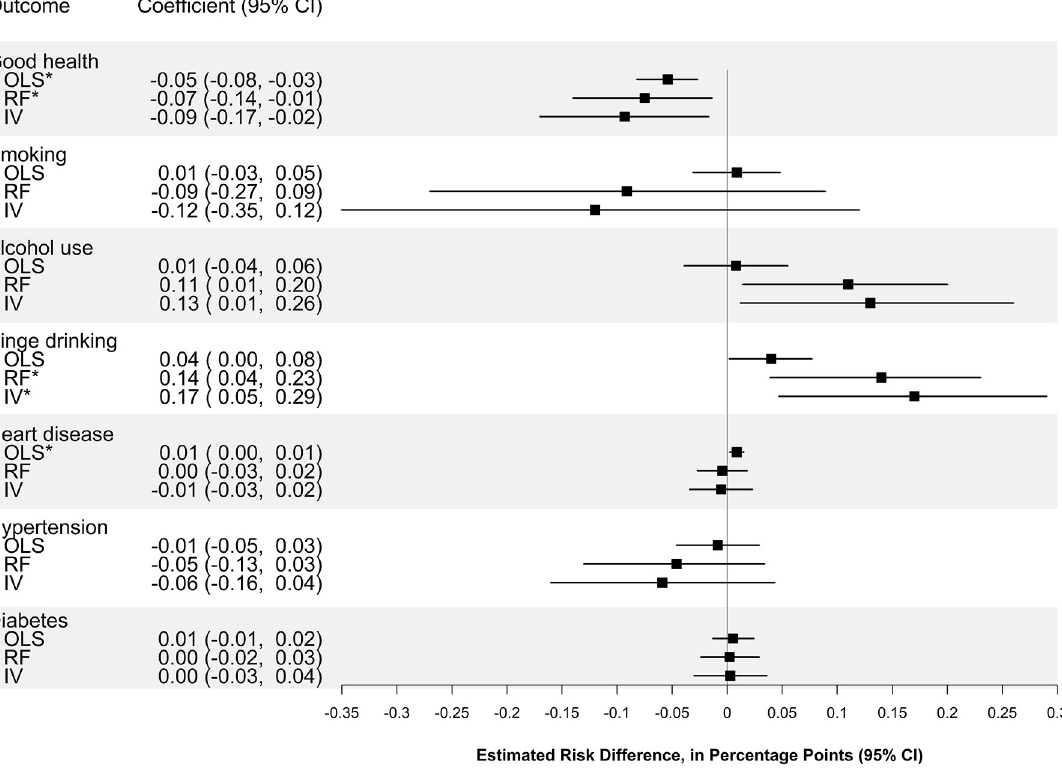
Fig 2. Association of school racial segregation with adult cardiovascular disease risk (binary outcomes). The squares represent the point estimate of the change in outcome per SD of the dissimilarity index, and the bars represent the 95% CIs. Estimates are derived from linear models adjusting for individual and school district characteristics as well as birth year and state fixed effects, with standard errors clustered at the individual and school district levels among 1,503 Black people from the PSID who had ever resided as a child in a school district that was under a court desegregation order (as of 1991) and had health outcomes observed during adulthood. � Indicates p -value < 0.05 after adjustment for multiple hypothesis testing. IV, instrumental variables; OLS, ordinary least squares; PSID, Panel Study of Income Dynamics; RF, reduced form.